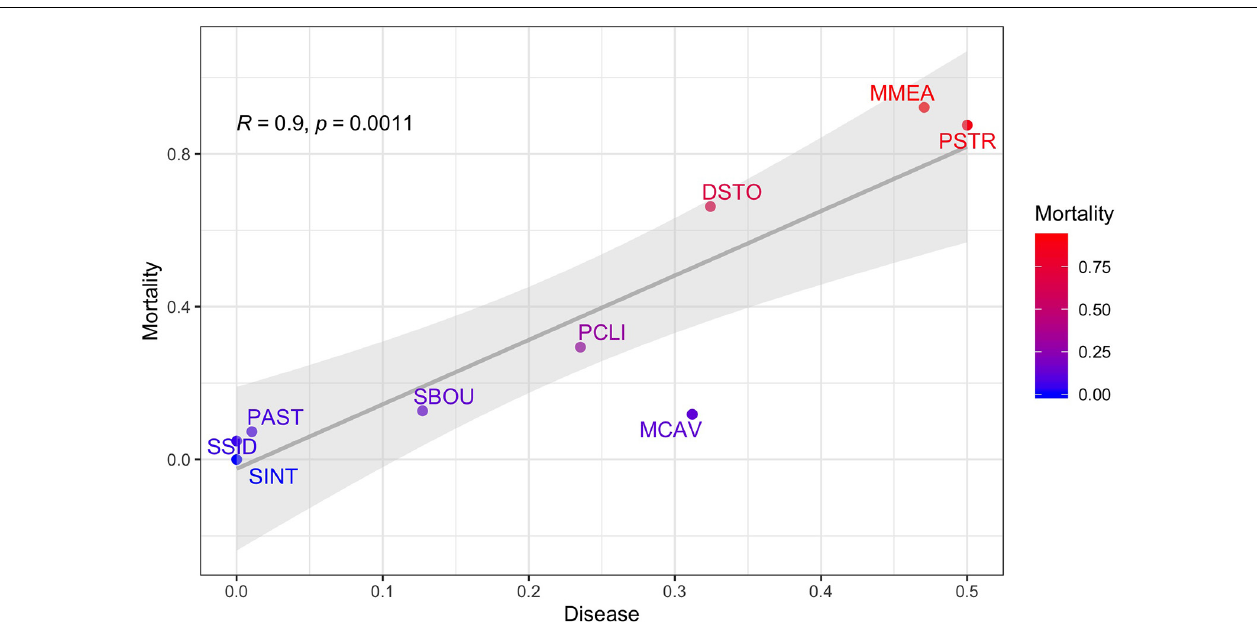
FIGURE 9 | Proportion of diseased corals plotted against coral mortality using the proportions from the top most abundant corals as the unit of replication. R and p -values from the correlation analyses are shown along with a fitted linear regression and the 95% confidence intervals. Coral mortality is colored from red (highest) to blue (lowest). Nine species include: Pseudodiploria clivosa (PCLI), Dichocoenia stokesi (DSTO), Psuedodiploria strigosa (PSTR), Montastrea cavernosa (MCAV), Meandrina meandrites (MMEA), Porites astreoides (PAST), Solenastrea bournoni (SBOU), Stephanocoenia intercepta (SINT), and Siderastrea siderea